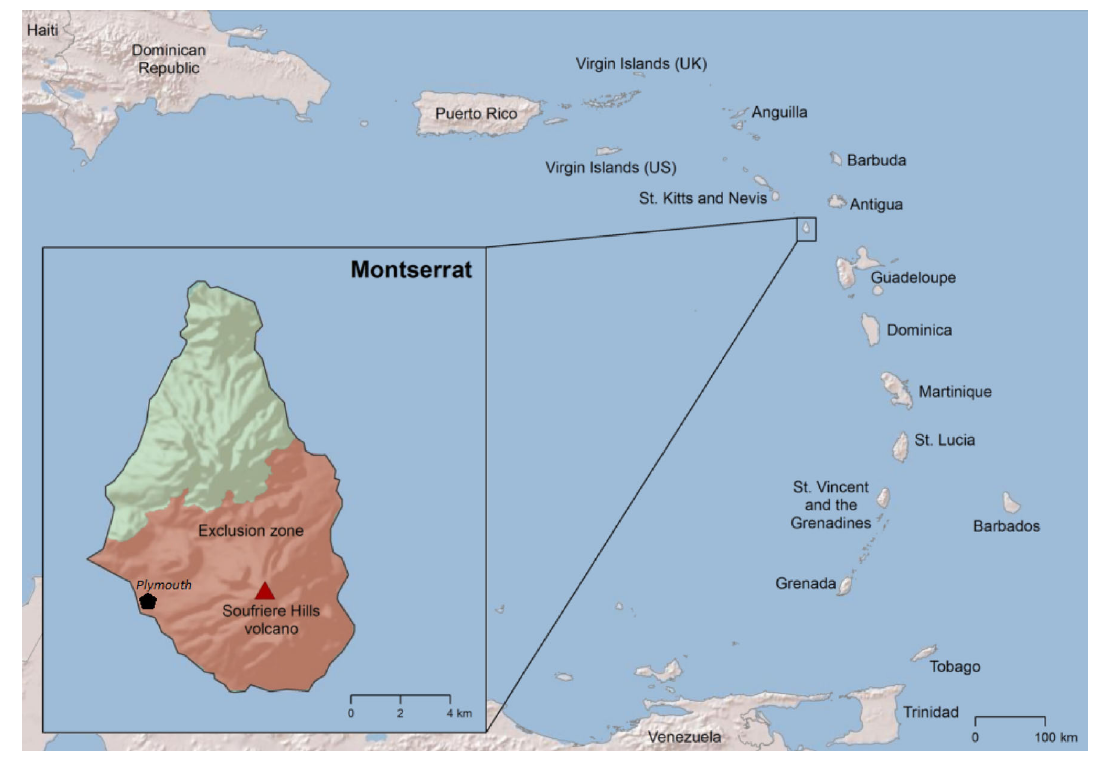
Fig. 1 Montserrat (inset) and its position within the wider Caribbean region. Source : Wilkinson